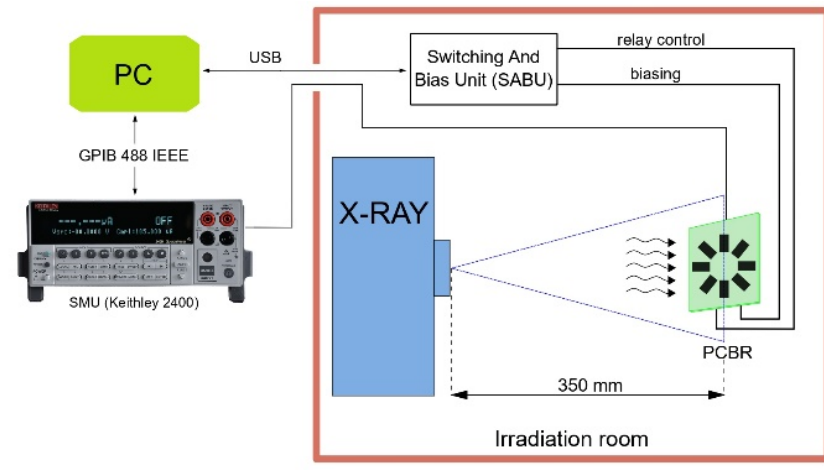
Figure 1. Block diagram of experimental setup.